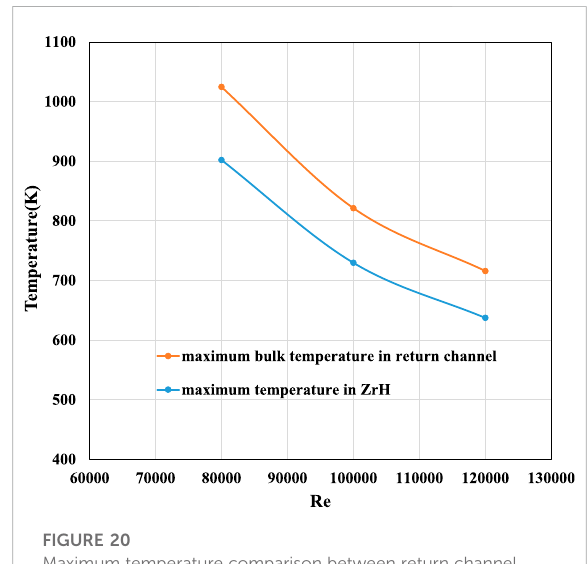
FIGURE 20 Maximum temperature comparison between return channel and ZrH x